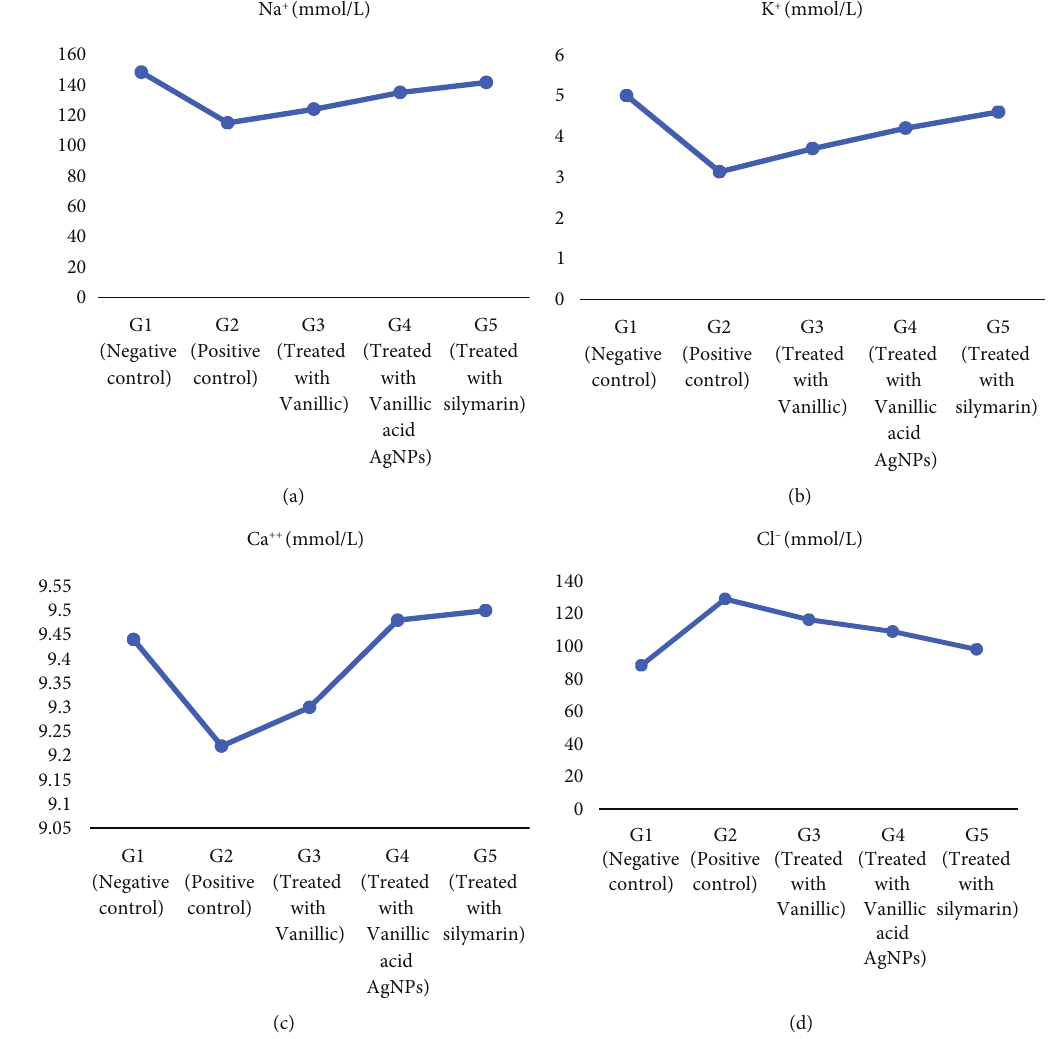
Figure 4: E ff ect of treating CCl -induced nephrotoxicity in male rats vanillic acid, vanillic acid AgNPs, and silymarin on serum electrolytes 4 levels. (a) Na + . (b) K + . (c) Ca ++ . (d) Cl −